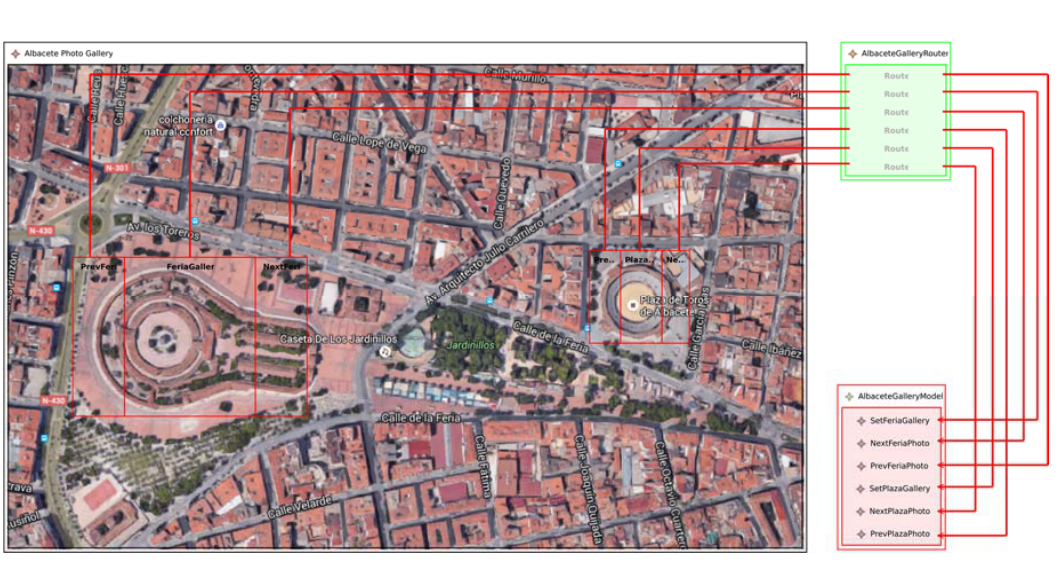
Figure 5. The platform independent model of the Albacete photo gallery application.